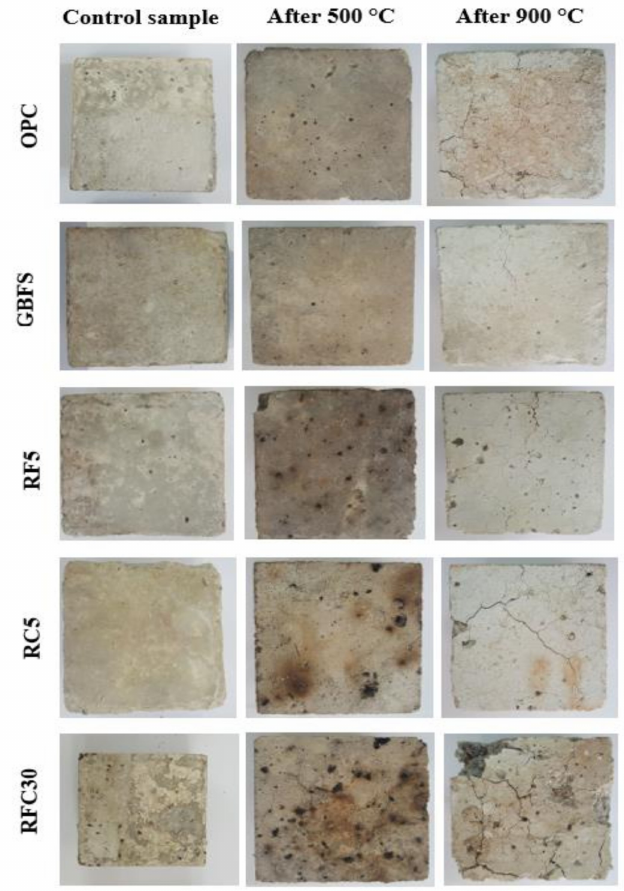
Figure 10. Surface texture of prepared concretes exposed to elevated temperatures.